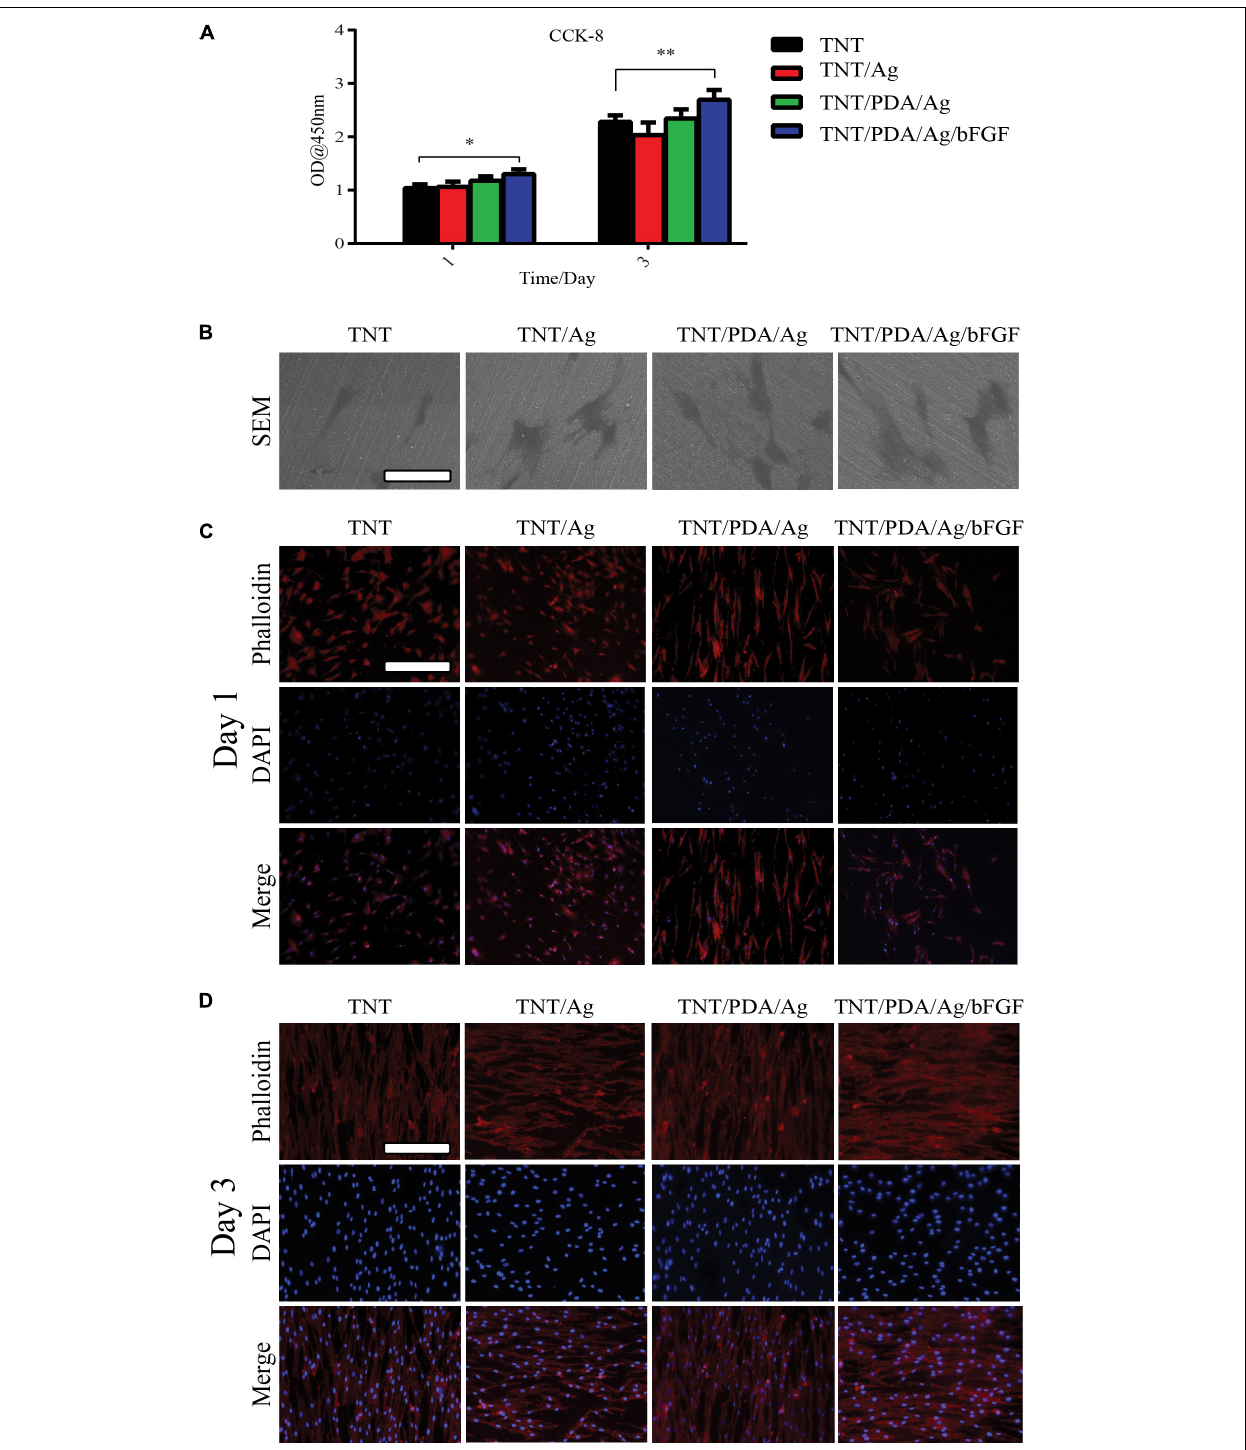
FIGURE 5 | Features of dental pulp stem cells (DPSCs) on modified Ti samples. (A) Determined by Cell Counting Kit-8 (CCK-8), on both days 1 and 3, DPSCs showed the highest viability on TNT/PDA/Ag/bFGF. (B) After 1-day culture of DPSCs on sample surfaces, cells were processed for SEM, which confirmed that DPSCs spread well on all modified Ti surfaces. Scale bar represents 20 µ m. (C,D) To visualize DPSCs on sample surfaces after 1- and 3-day culture, cells were labeled by phalloidin-TRITC (red) and DAPI (blue). During the first day of culture of DPSCs on modified Ti surfaces, cells on TNT/PDA/Ag and TNT/PDA/Ag/bFGF were aligned. On day 3, DPSCs were well aligned in high density on all surfaces. Scale bar represents 20 µ m. Data are presented as mean ± standard deviation; ∗ p < 0.05, ∗∗ p < 0.01.